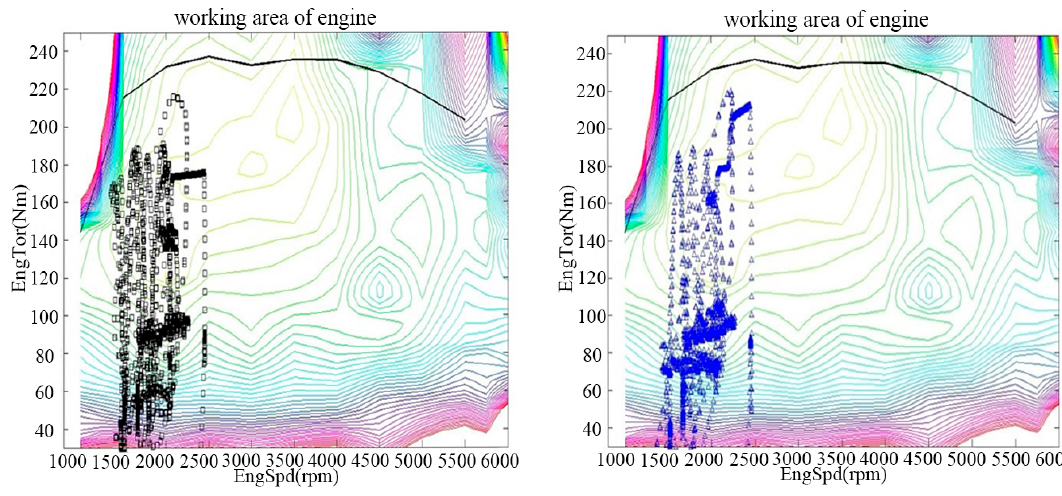
Figure 23. Engine working points distribution before and after optimization.